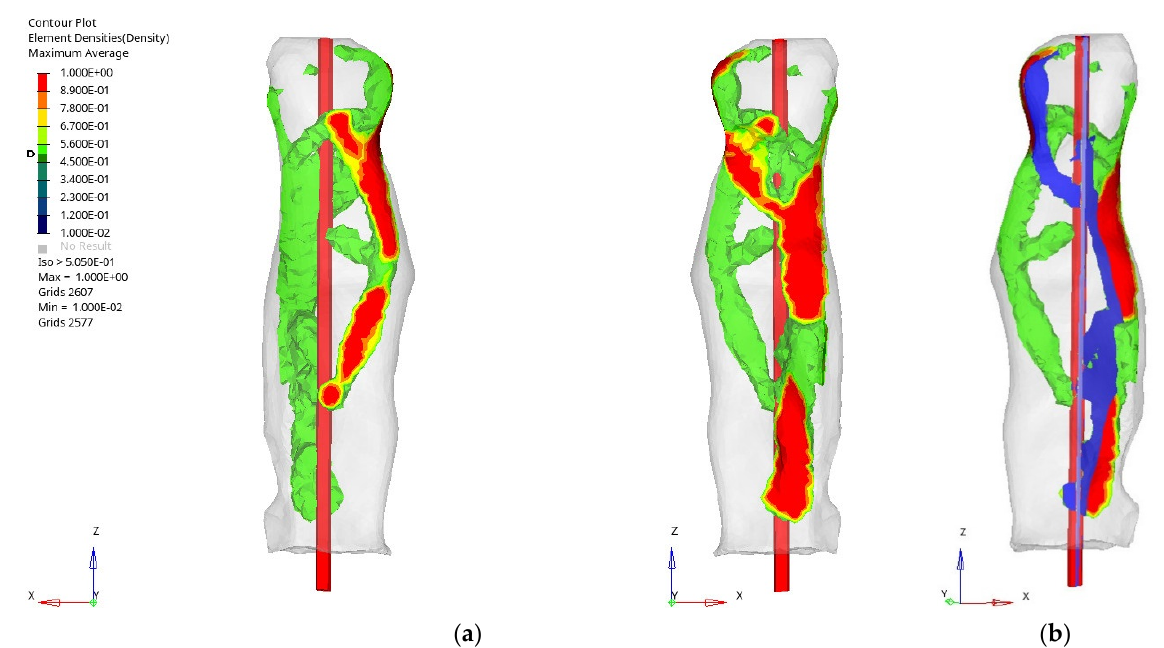
Figure 7. CBWA case: density distribution ( a ) Back and front View) ( b ) Two intersecting sectional views (in blue).